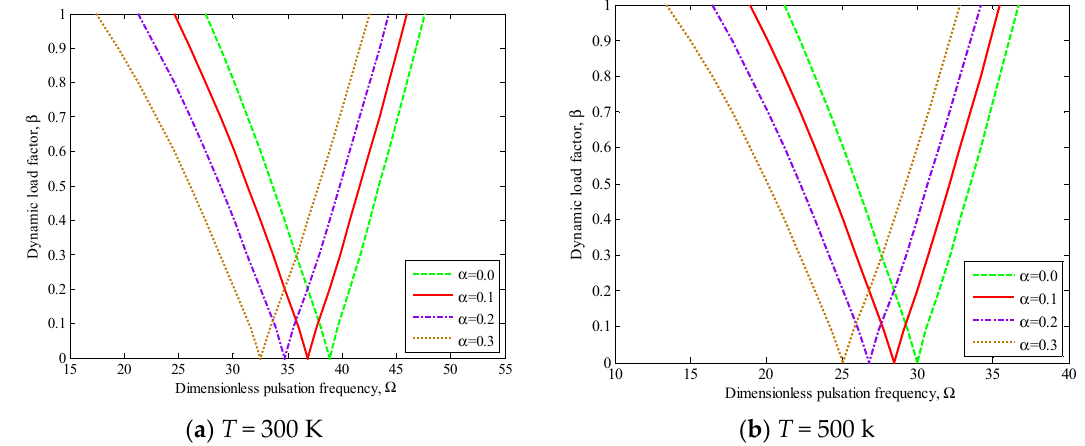
Figure 7. Static load factor effect on the DIR of the SLGS embedded on an elastomeric foundation.